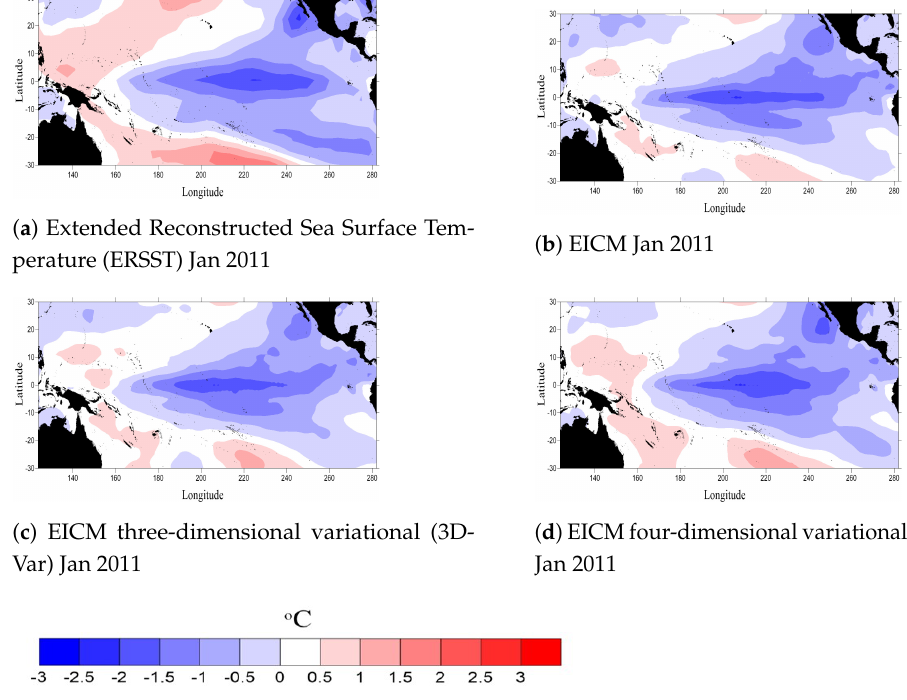
Figure 3. Pacific region sea surface temperature anomaly (SSTA) values ( ◦ C) in January 2011 from ERSST measurements ( a ), and the SSTA prediction results at one-month lead time of EICM ( b ), EICM 3D-Var ( c ), and EICM 4D-Var ( d